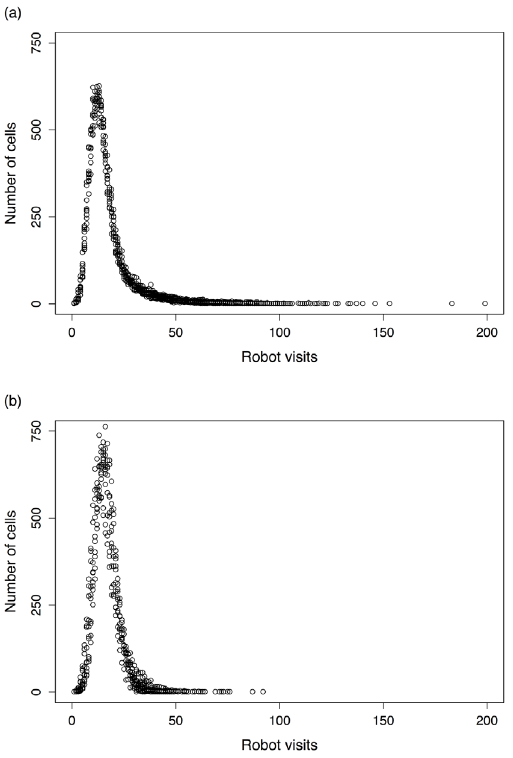
Figure 3. Movement behaviour for (a) ANN and (b) GRN-based robots. The X-axis represents the number of robot visits, over 50 simulations, while the Y-axis represents the number of cells that have experienced that specific number of visits (non-cumulative). Cells that have seen many visits (which is mainly true for the ANN robots) represent robots that spend much time visiting the same cell (i.e. robots have been trapped in these cells for a comparatively longer time), which implies that they do not explore the area as efficiently.